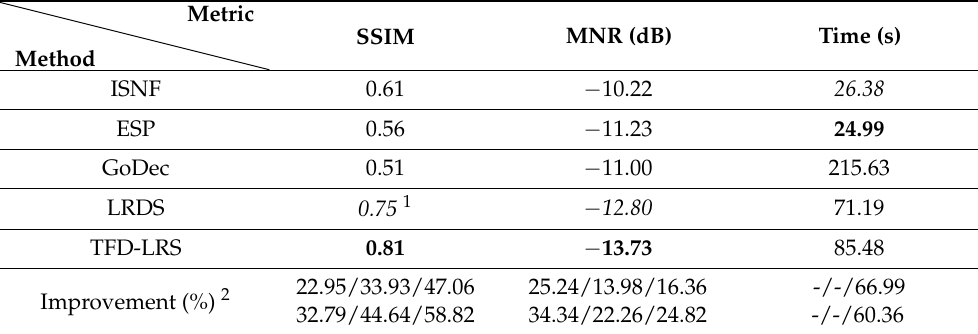
Table 6. Performance comparison of RFI mitigation algorithms for the measured SAR data with simulated RFI.